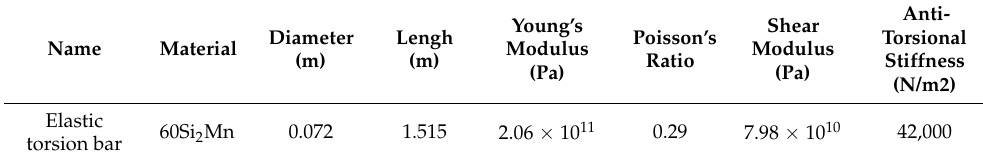
Table 1. Torsion bar material